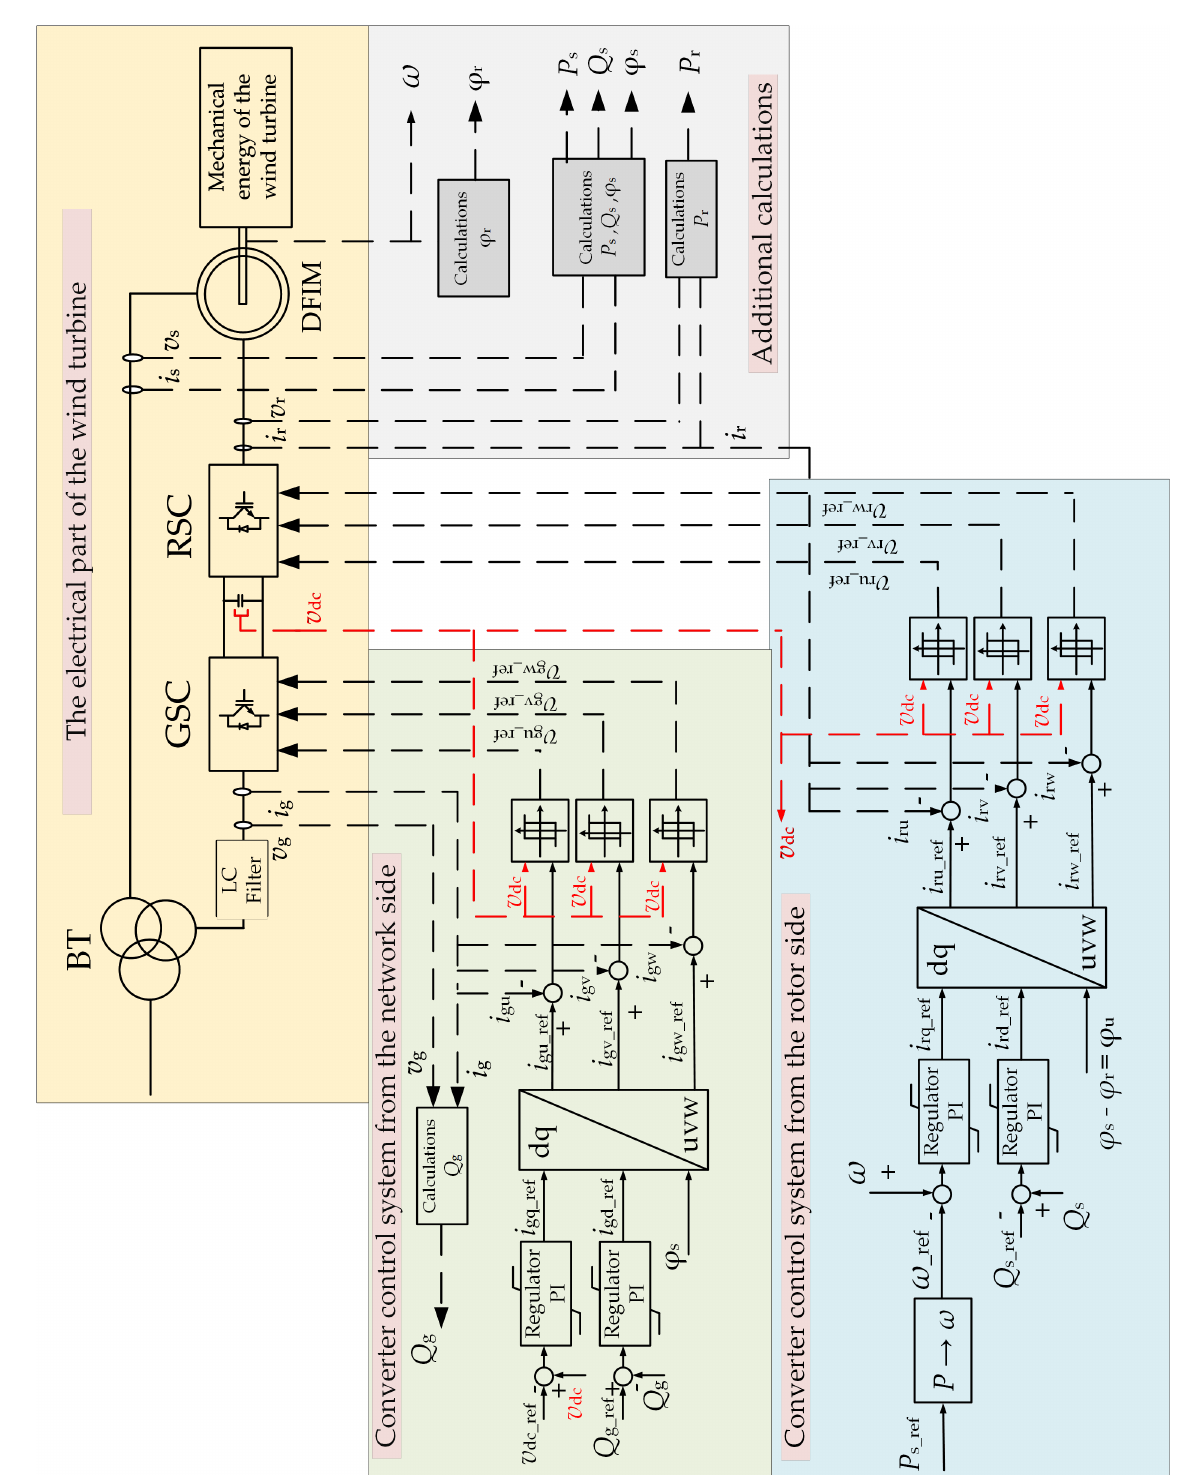
Figure 12. Schematic diagram of a wind turbine with a control